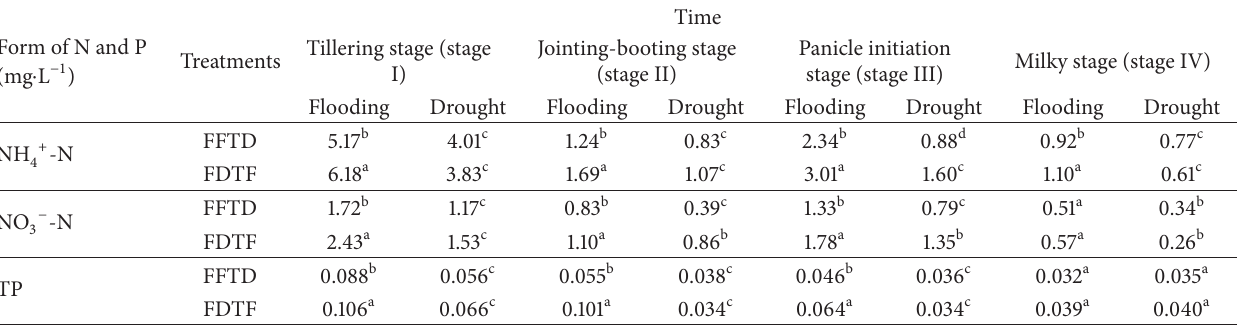
Table 3: Mean TP, NH 4+ -N, and NO 3− -N concentrations in percolation water at different stages during the time of flooding and drought.